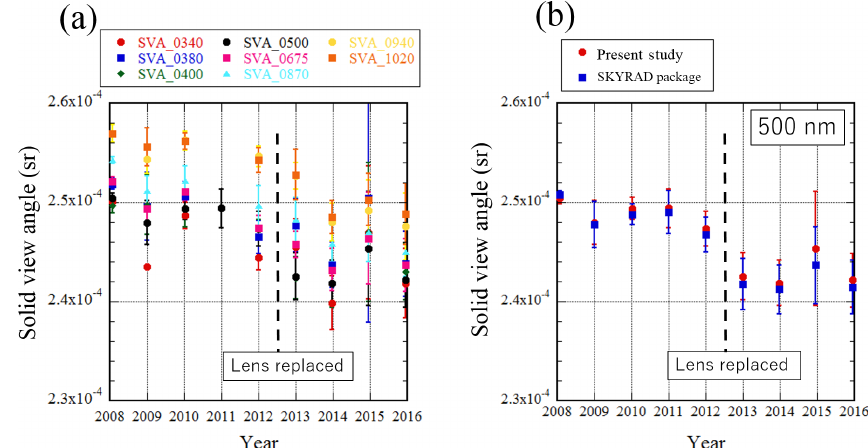
Figure 5. SVAs in the visible and near-infrared region (Si photodiode) from 2008 to 2016. The data were taken at MLO over a month in October and November every year. (a) SVA calculated by the corrected method in this study, (b) SVA at a wavelength of 500nm calculated by both the corrected and the current SKYRAD package methods.